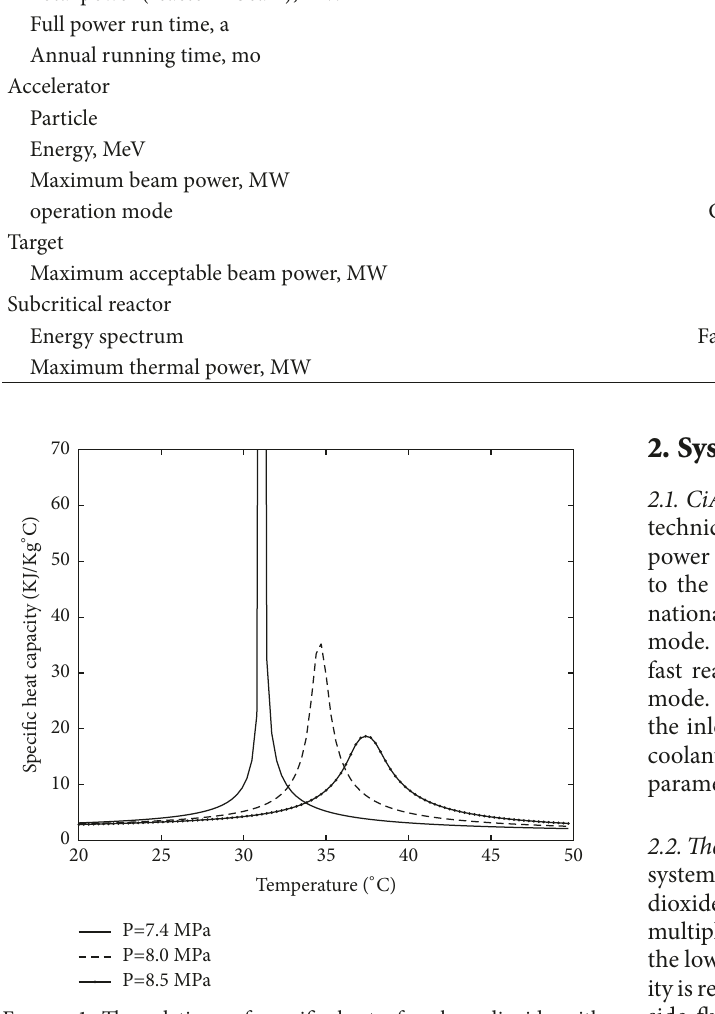
Figure 1: The relations of specific heat of carbon dioxide with